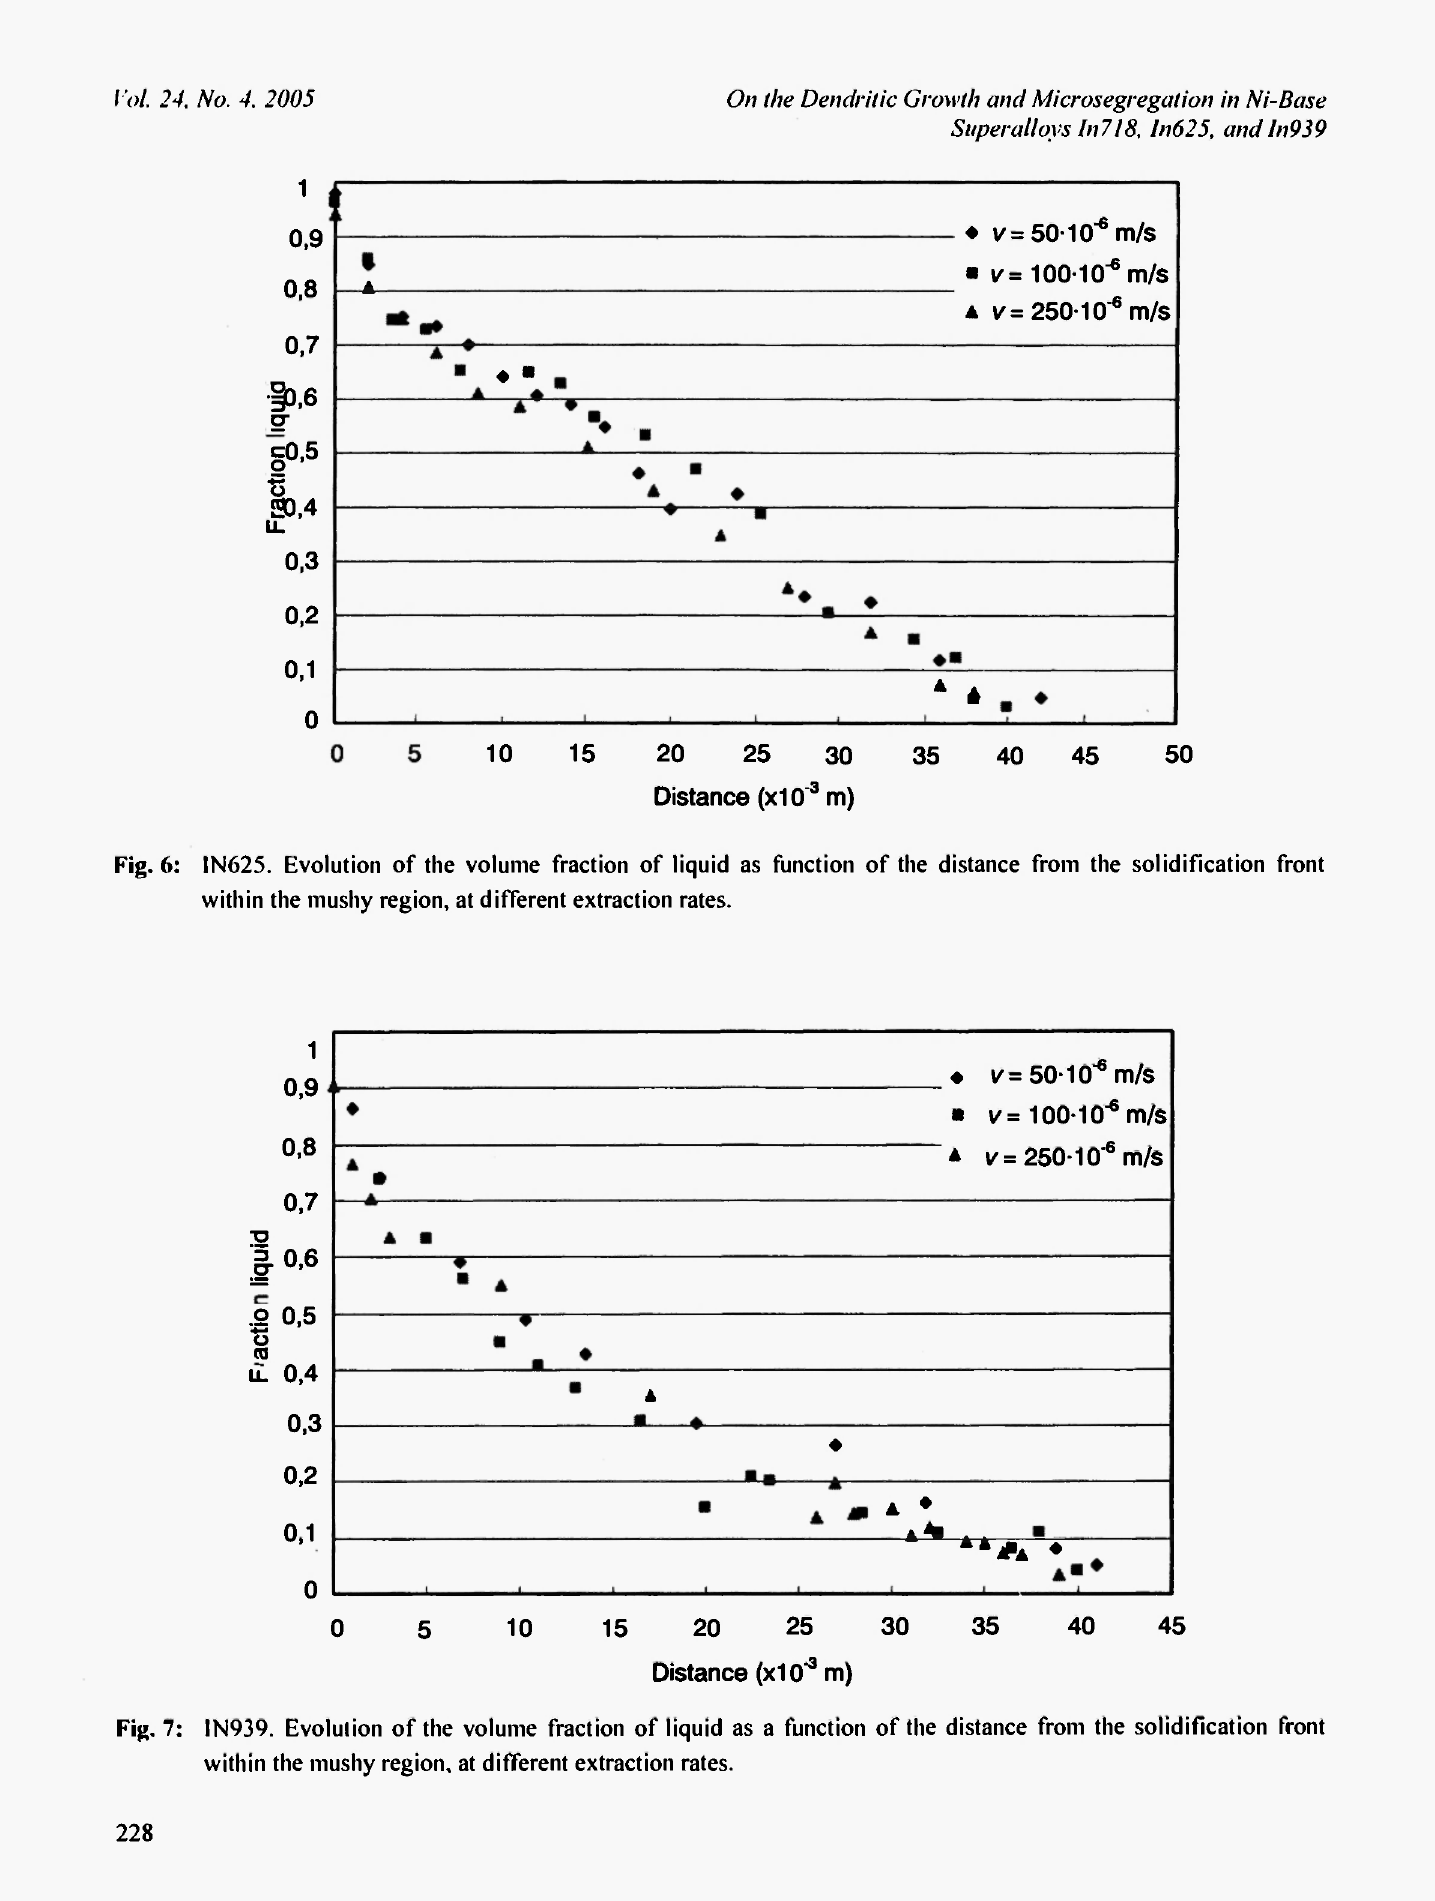
Fig. 7: IN939. Evolution of the volume fraction of liquid as a function of the distance from the solidification front within the mushy region, at different extraction